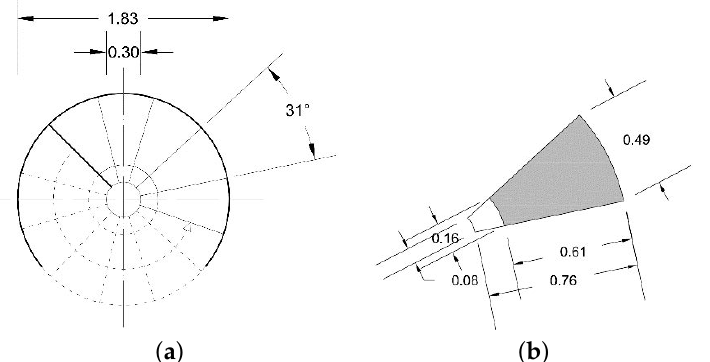
Figure 5. Spiral staircase in the tower of Nisida: ( a ) geometric layout; ( b ) plan of the step with dimensions (Unit: